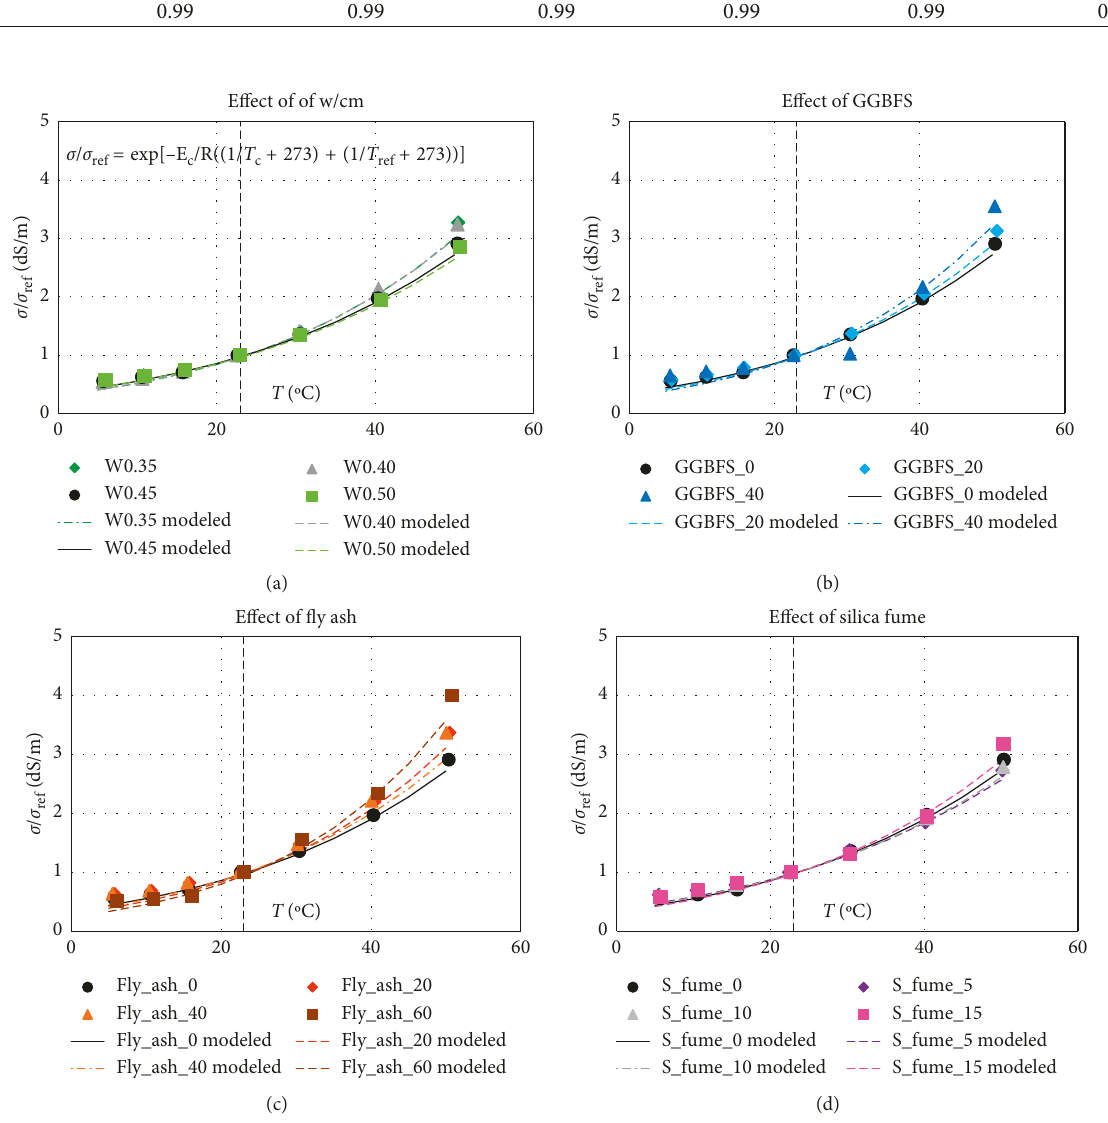
ref at various T c based on ATC (equation 2) for all mixtures. Vertical dashed line corresponds to T ref